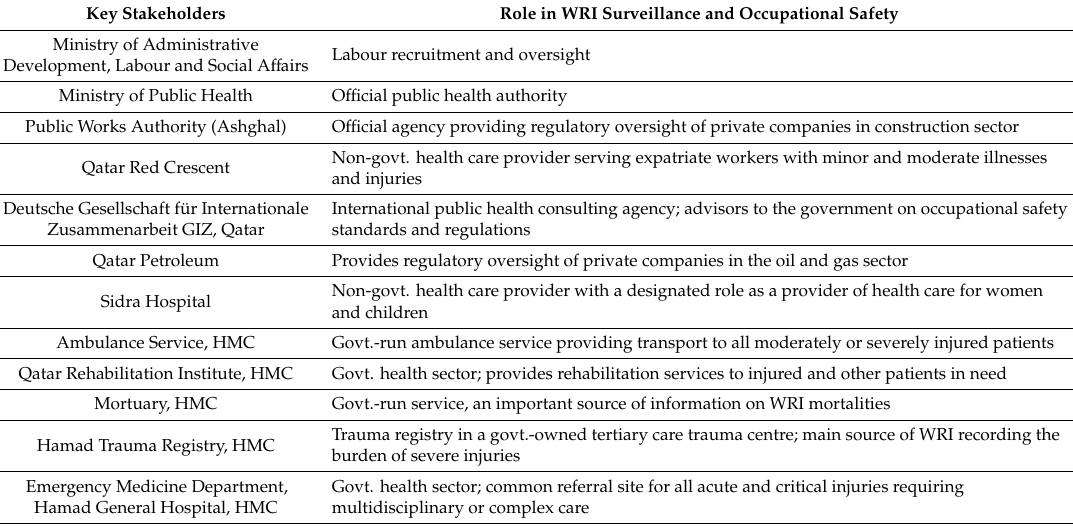
Table 1. Stakeholders’ role in work-related injuries (WRIs),